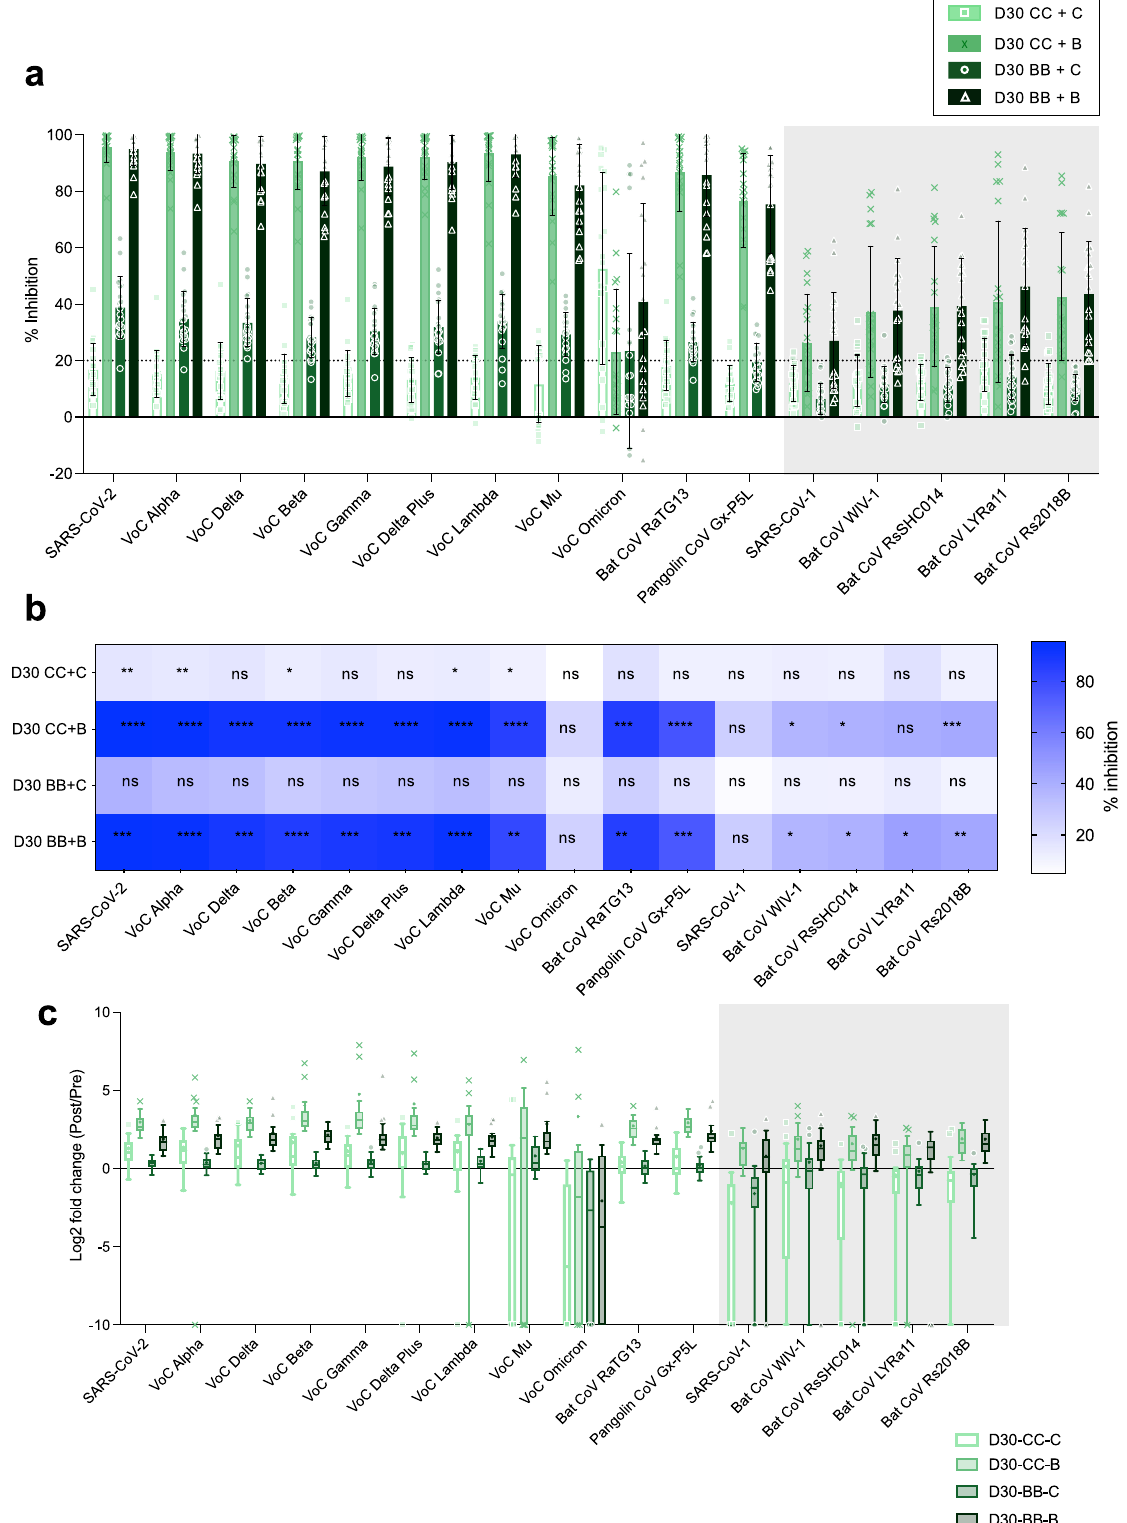
Fig. 3 | mRNA third dose vaccination regardless of priming increases antibody breadth.a The%antibodyinhibitionofACE2bindingtoRBDwasdeterminedfor third dosevaccinationafterCC orBB prime foreitherB orC boost (each group n = 20subjects)1monthpostthirddosevaccination. b Heatmaprepresentation of%inhibitionof1monthpostvaccination(from a ). c Foldchangeofpreversus